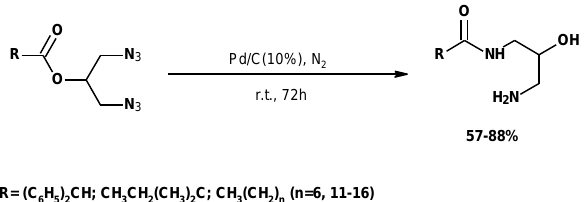
Figure 9. Synthesis of monoamides by hydrogenation of the corresponding